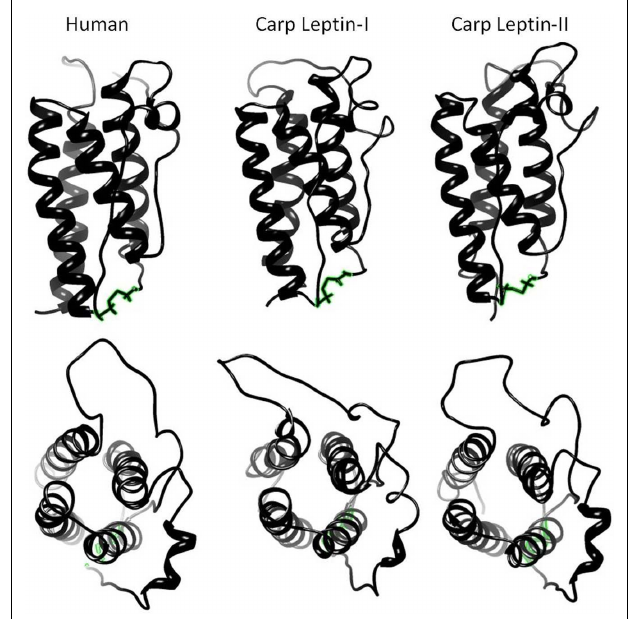
FIGURE 4 |Threading models of human and carp leptins showing characteristic four-helix bundle and disulfide bond. Models were predicted using LOMETS (Wu and Zhang, 2007) threading server and energy minimized (with disulfide bonds) usingYASARA (www.yasara.org) with AMBER03 force field (Duan et al.,